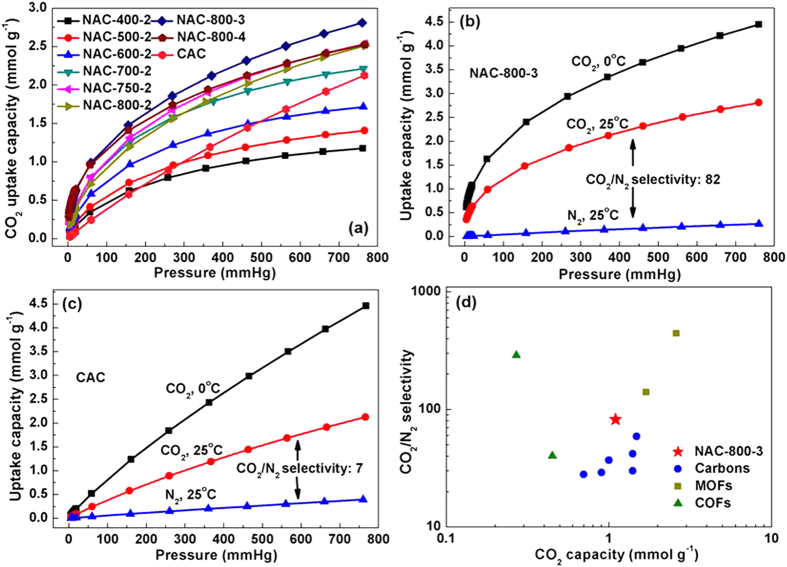
(a) CO2 adsorption isotherms of all NAC samples at 1 bar and 298 K; (b) Adsorption isotherms of NAC-800-3 for CO2 at 273 and 298 K, and N2 at 298 K; (c) Adsorption isotherms of CAC for CO2 at 273 and 298 K, and N2 at 298 K; (d) Comparison of CO2 adsorption capacity (298 K, 0.1 bar) and CO2/N2 selectivity of NAC-800-3 with different types of representative solid physisorbents (carbons4567891011, MOFs121314, COFs1516).